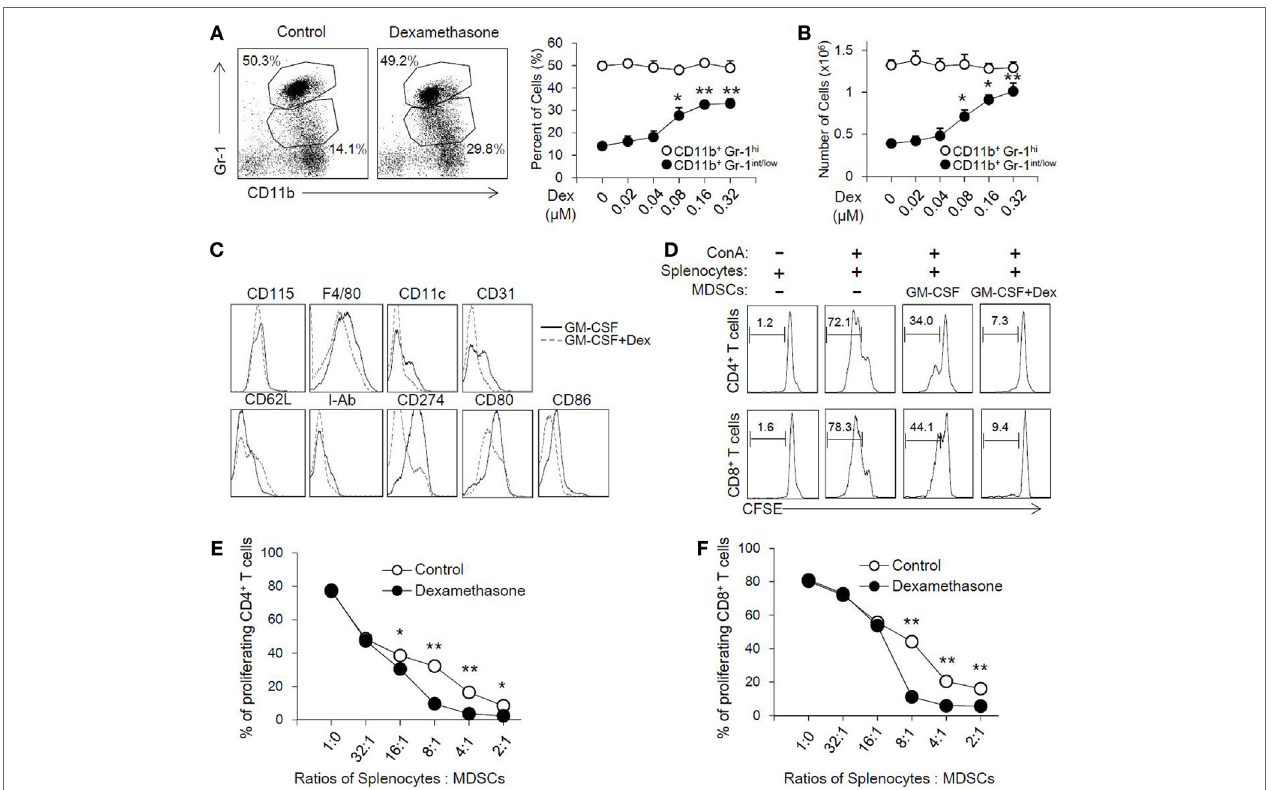
FigUre 1 | Dexamethasone (Dex) increases the cell number of CD11b + Gr-1 int/low Myeloid-derived suppressor cells (MDSCs) with an enhanced suppressive function in vitro . MDSCs were induced from bone marrow cells in the presence of granulocyte macrophage colony stimulating factor (GM-CSF), with or without Dex for 4 days. The percentage (a) and cell number (B) of MDSCs induced by GM-CSF or GM-CSF + Dex were shown. The phenotype markers (c) of MDSCs induced in vitro were also summarized by flow cytometry. (D) CFSE-labeled splenic cells (2 × 10 5 per well) were stimulated by ConA (2 µg/ml), and MDSCs induced by GM-CSF or GM-CSF + Dex were added at different ratios between splenic cells and MDSCs for 72 h. The pattern of proliferation was examined by flow cytometric analysis of CFSE dilution in the gated CD4 + and CD8 + T cells. The percentages indicated CFSE dilution in the gated T cell population (number of splenic cells and MDSCs: 2 × 10 5 and 0.25 × 10 5 ). The inhibitory rates in CD4 + T cells (e) and CD8 + T cells (F) were calculated based on the proliferation rates determined by flow cytometry analysis. The data (Mean ± SEM) are representative from three independent experiments (* P < 0.05, ** P <